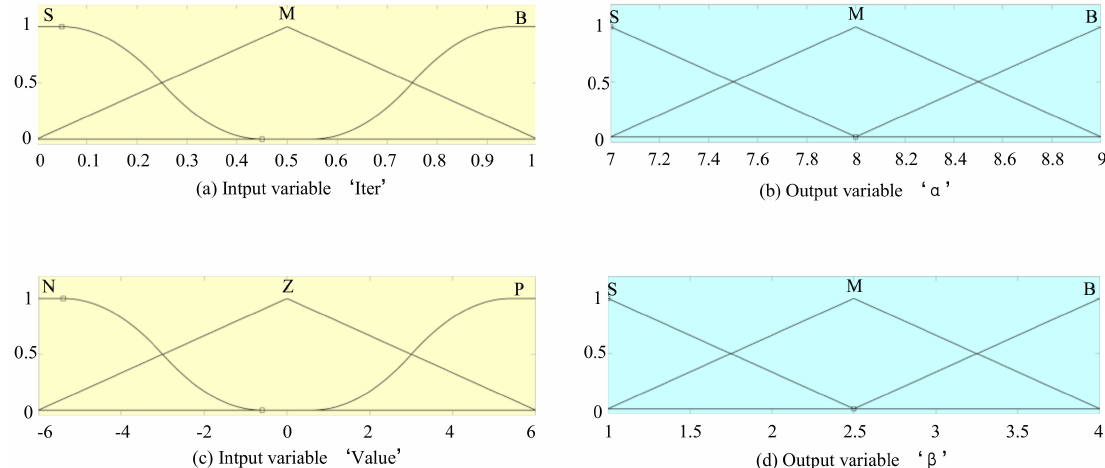
Figure 4. The function of the fuzzy input and output variable.